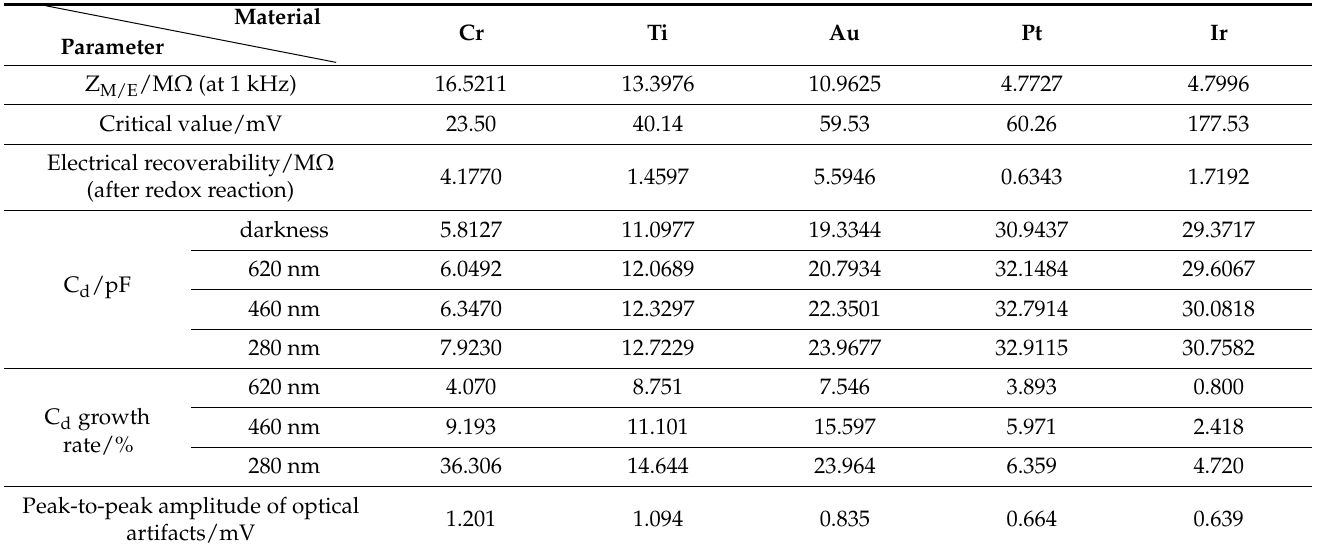
Table 2. Comparison of various parameters of microelectrodes made by different surface materials. Parameter